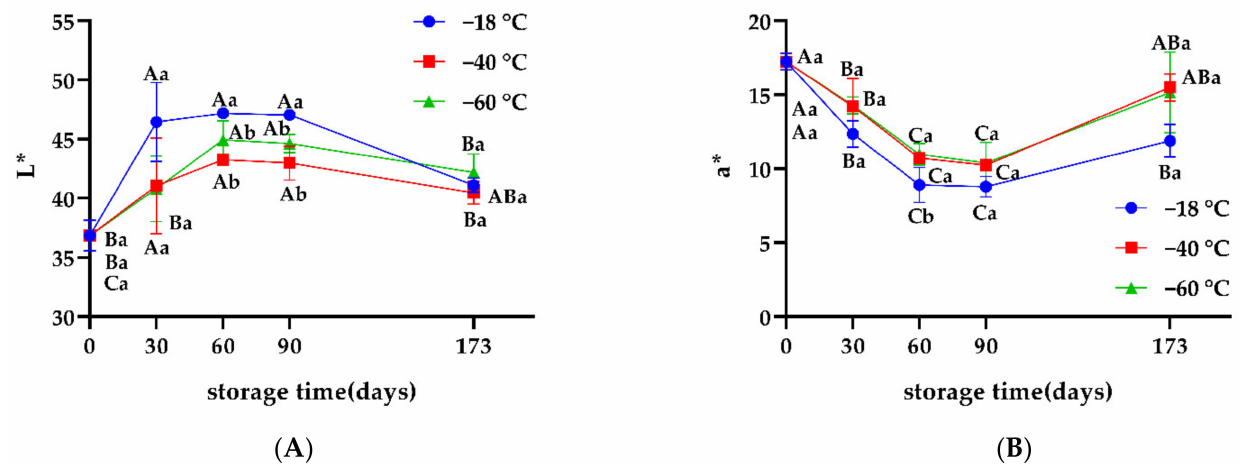
Figure 4. ( A ) Effects of different freezing storage temperatures on L* of snowflake beef ( n = 4); ( B ) Effects of different freezing storage temperatures on a* of snowflake beef ( n = 4); ab represents significant differences of different freezing temperatures for the same storage time; ABC represents significant differences of different freezing times for the same storage temperature.